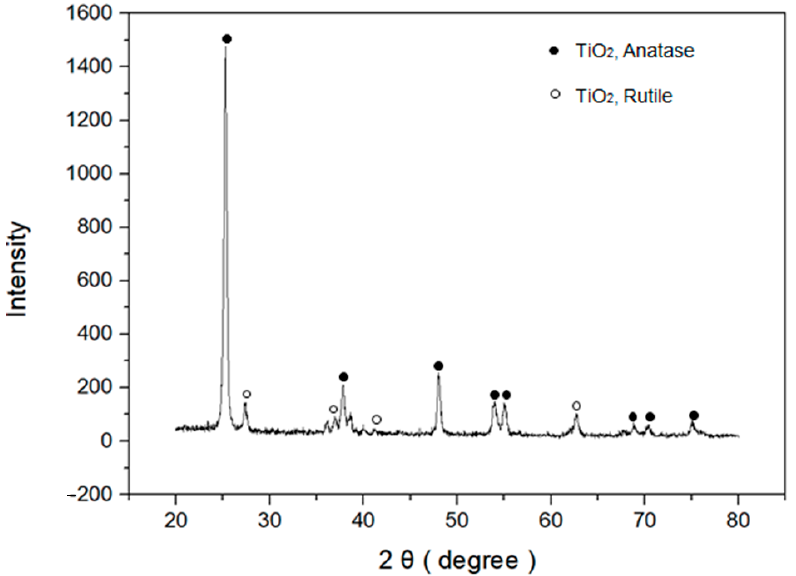
Figure 3. XRD pattern of deposited TiO 2 NPs on Pt IDE.